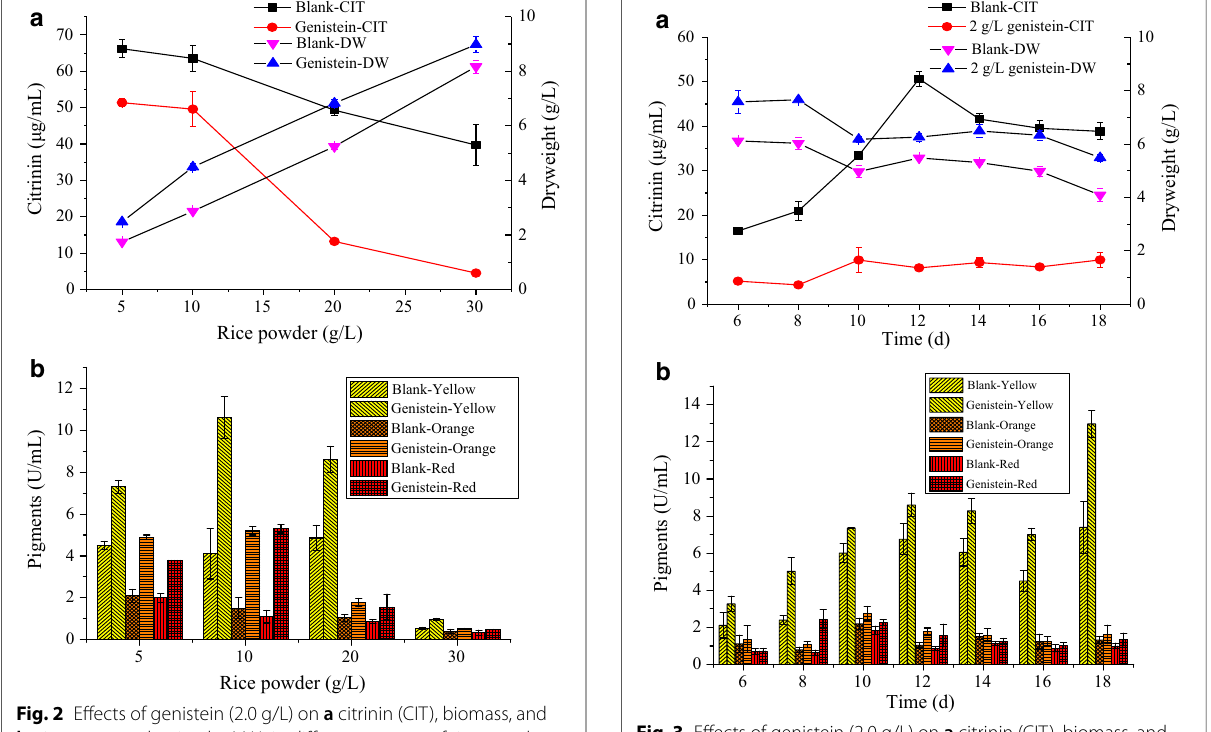
Fig. 3 Effects of genistein (2.0 g/L) on a citrinin (CIT), biomass, and b pigments production by MAL at 30 °C, 180 rpm during different liquid-state fermentation time. Significant differences of different the dots and the columns at p <